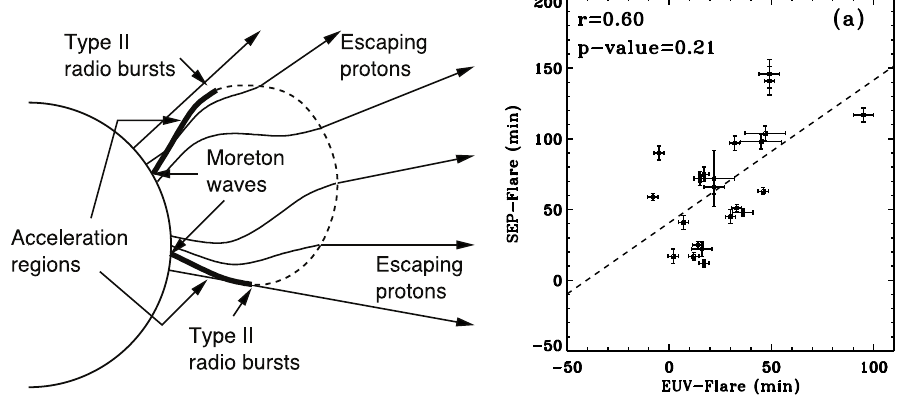
Figure 50: Left : Cartoon illustrating the concept of SEP acceleration at refracting coronal shocks in which the observer is magnetically connected to the downstream side of the shock. Right : SEP onset time plotted against EUV wave arrival time at the connecting magnetic footpoint (both times are given relative to the time of the associated flare). The dashed line is a linear least squares fit to the data, and 𝑟 is the correlation coefficient. Images reproduced with permission from [left] Vainio and Khan (2004) and [right] from Park et al. (2013), copyright by